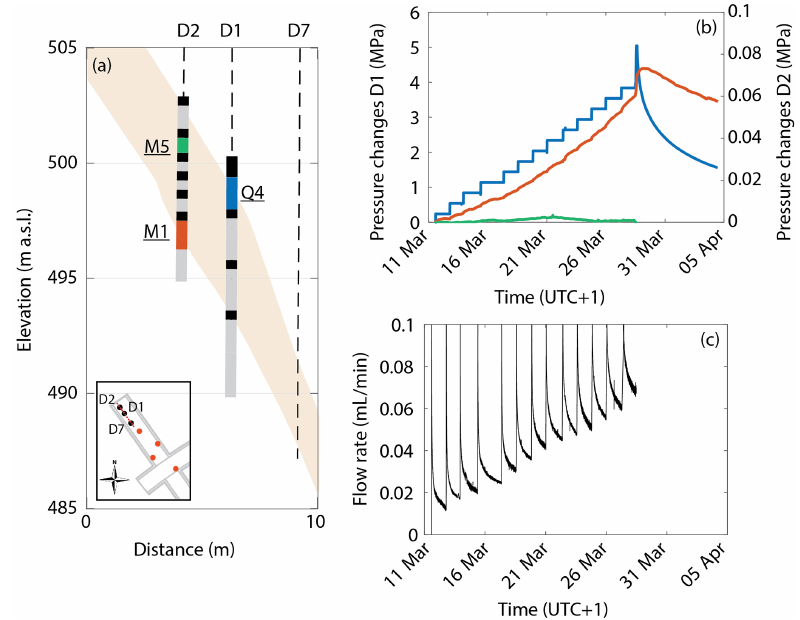
Figure 9. (a) Projection on plane of boreholes BCS-D1 and BCS-D2 and their intervals. The inlet shows the location of the boreholes and the orientation of the plane. (b) Pressure changes in the injection interval Q4 (blue) and response at two intervals in the fluid-monitoring borehole (M1 in red and M5 in green). The positions of the monitor intervals with respect to the injection interval are shown in (a) . (c) Flow rate at the syringe pump.